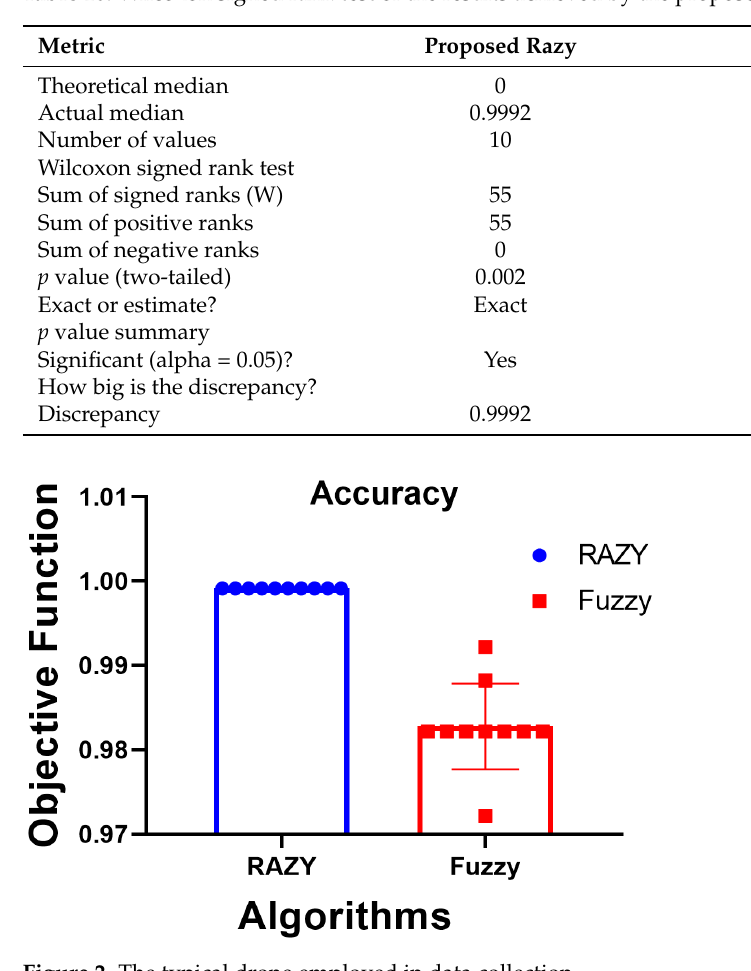
Table 10. Wilcoxon signed rank test of the results achieved by the proposed Razy approach.